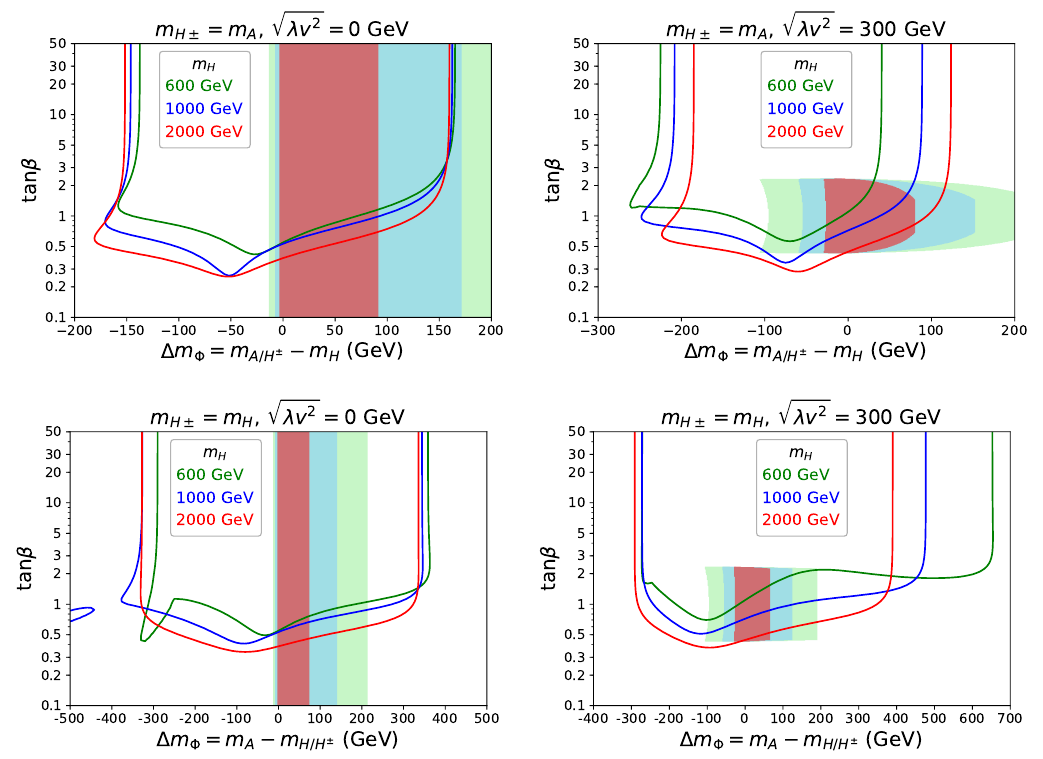
tan (cid:12) (cid:0) (cid:11) ) = 0. In the upper two panels, (cid:0) p (cid:21)v 2 is set to 0 (left panels) and m H=H (cid:6) . (cid:0)